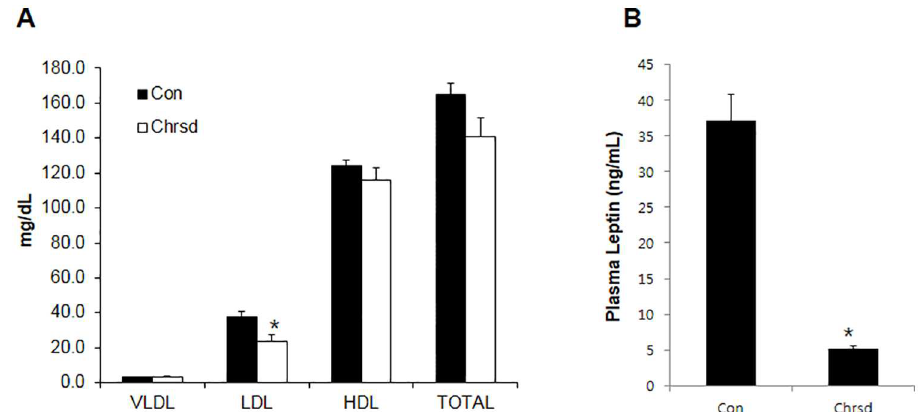
Fig 2. Effect of Chardonnay grape seed flour (ChrSd) on (A) plasma lipids and (B) leptin concentration. Male diet-inducedobese mice (DIO) were fed high-fat (HF) diets containing 5% microcrystalline cellulose(MCC, control) or 10% (w/w) ChrSd for 5 weeks, and blood was collectedin a food- deprived state. VLDL, very low-density lipoprotein;LDL, low-density lipoprotein;HDL, high-densitylipoprotein. Data are expressedas mean ± SE; n = 8–10/group. * P < 0.05.